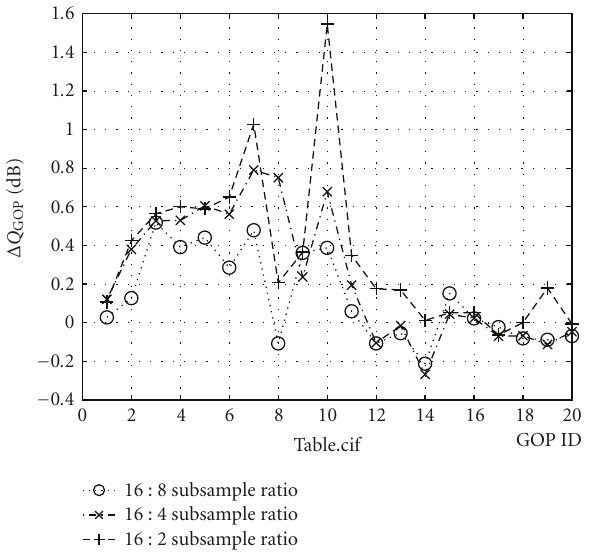
Figure 5: The statistical distribution of Δ GOP versus ZMVC.